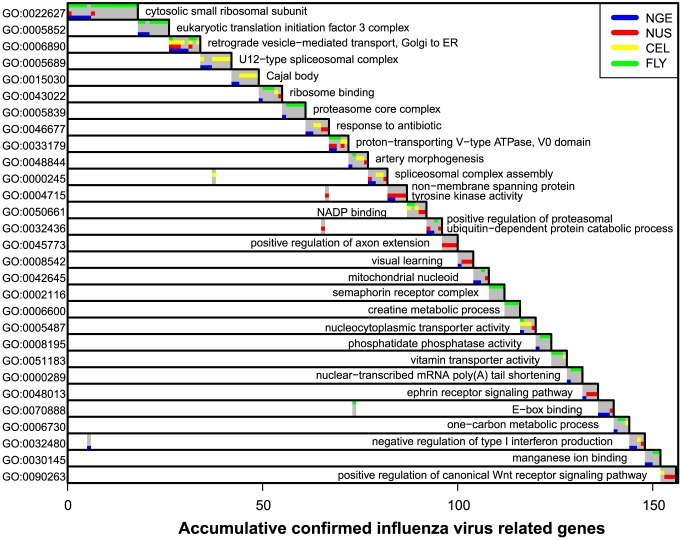
Dominant Gene Ontology terms identified in analysis of combined gene list.The multi-functional analyzer (MFA) applied to the combined list of 614 influenza-involved genes produced 91 GO terms in the maximum a posteriori (MAP) estimate of activated terms. The dominant terms are shown here, with color bars to indicate the study responsible for identifying the gene. The MFA-identified category having highest overlap with the 614-gene list is GO:0022627 (top row), the overlap being 18 genes (horizontal axis). These genes and this category are removed from the system, and then the category having the highest overlap with the remainder is identified (GO:0005852), and so on until the overlap is less than four genes. Shading in the sub-diagonal indicates genes also annotated to previously named categories.